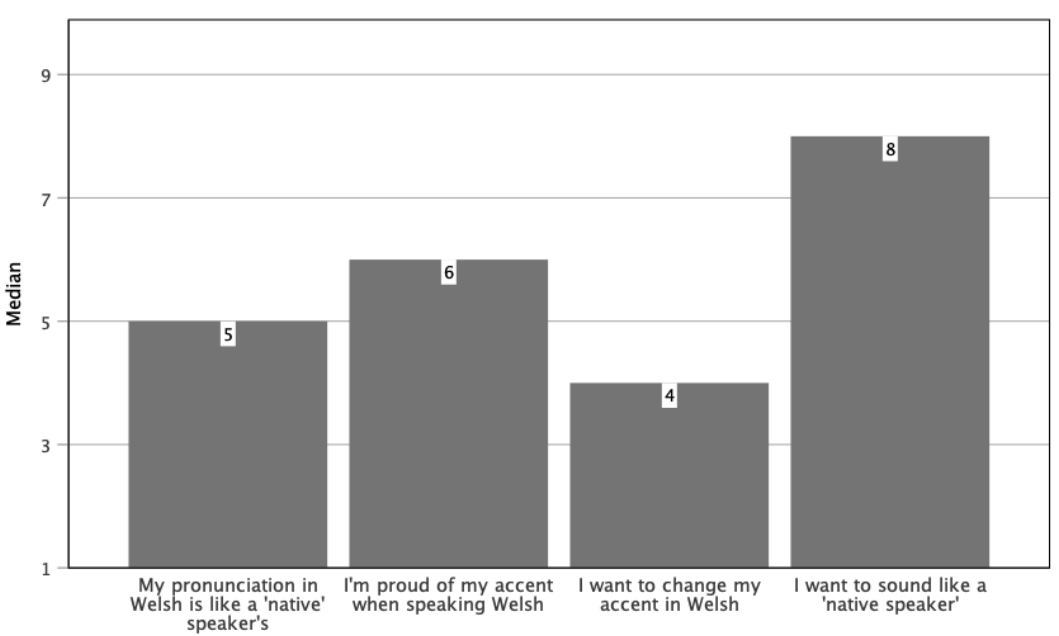
Figure 1. Median scores for statements on accent and pronunciation (1 = Not at all, 9 = Completely).